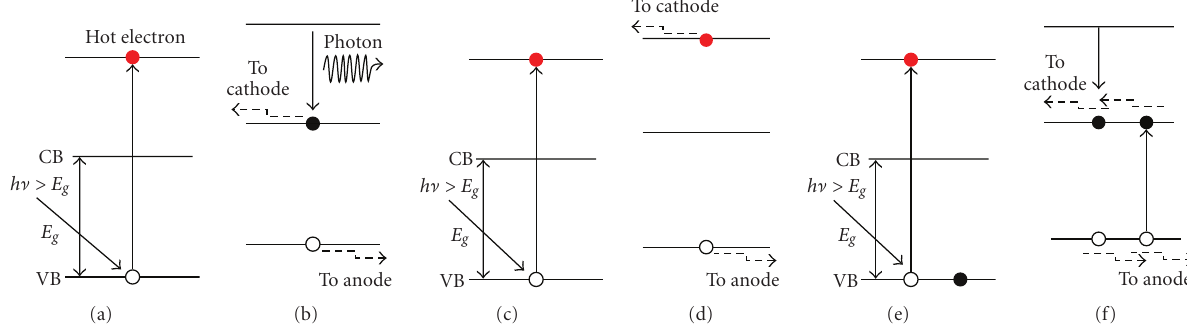
Figure 4: (a) A photon with energy ( h ν ) greater than band gap energy ( E g ) strikes on solar cell and excites an electron to Conduction Band (CB) from Valence Band (VB); (b) the extra energy ( h ν – E g ) is released as phonon; (c) a photon with energy ( h ν ) greater than band gap energy ( E g ) strikes on solar cell and excites an electron to CB from VB; (d) the extra energy ( h ν – E g ) is used to produce higher voltage by h ν – E g ; (e) a photon with energy ( h ν ) more than band gap energy ( E g ) strikes on solar cell and excites an electron; (f) extra energy ( h ν – E g ) is used to excites one more electron from VB to CB.